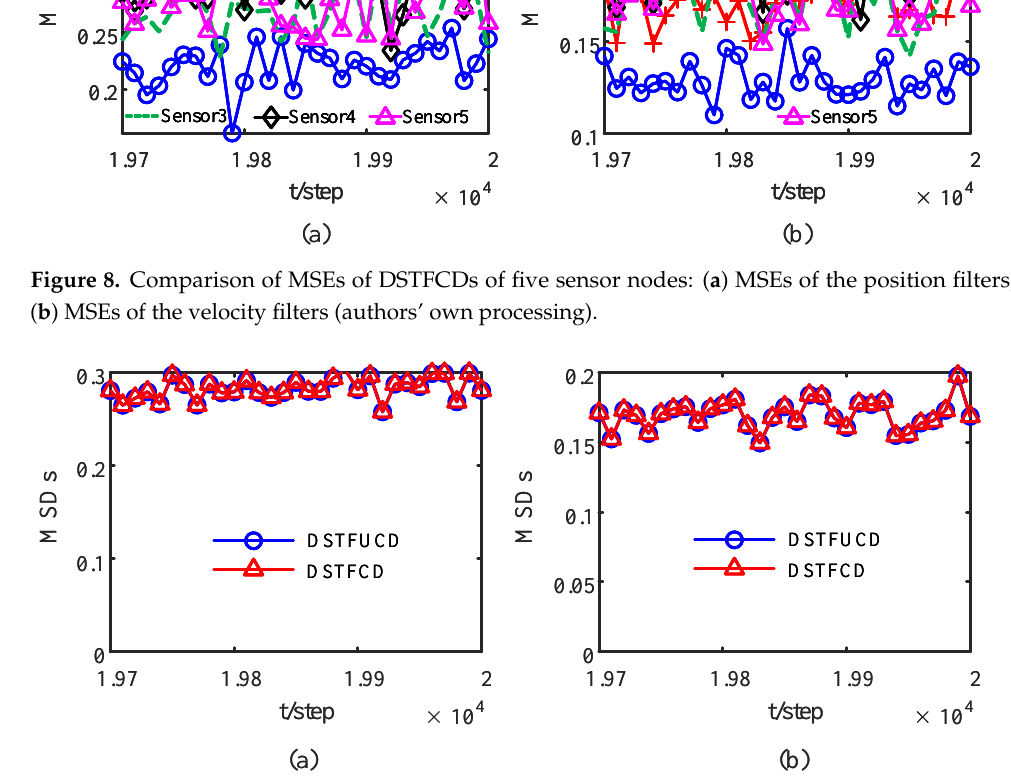
Figure 9. Comparison of MSDs of DSTFCDs and DSTFUCDs of five sensor nodes: ( a ) MSDs of the position filters; ( b ) MSDs of the velocity filters (authors’ own processing).